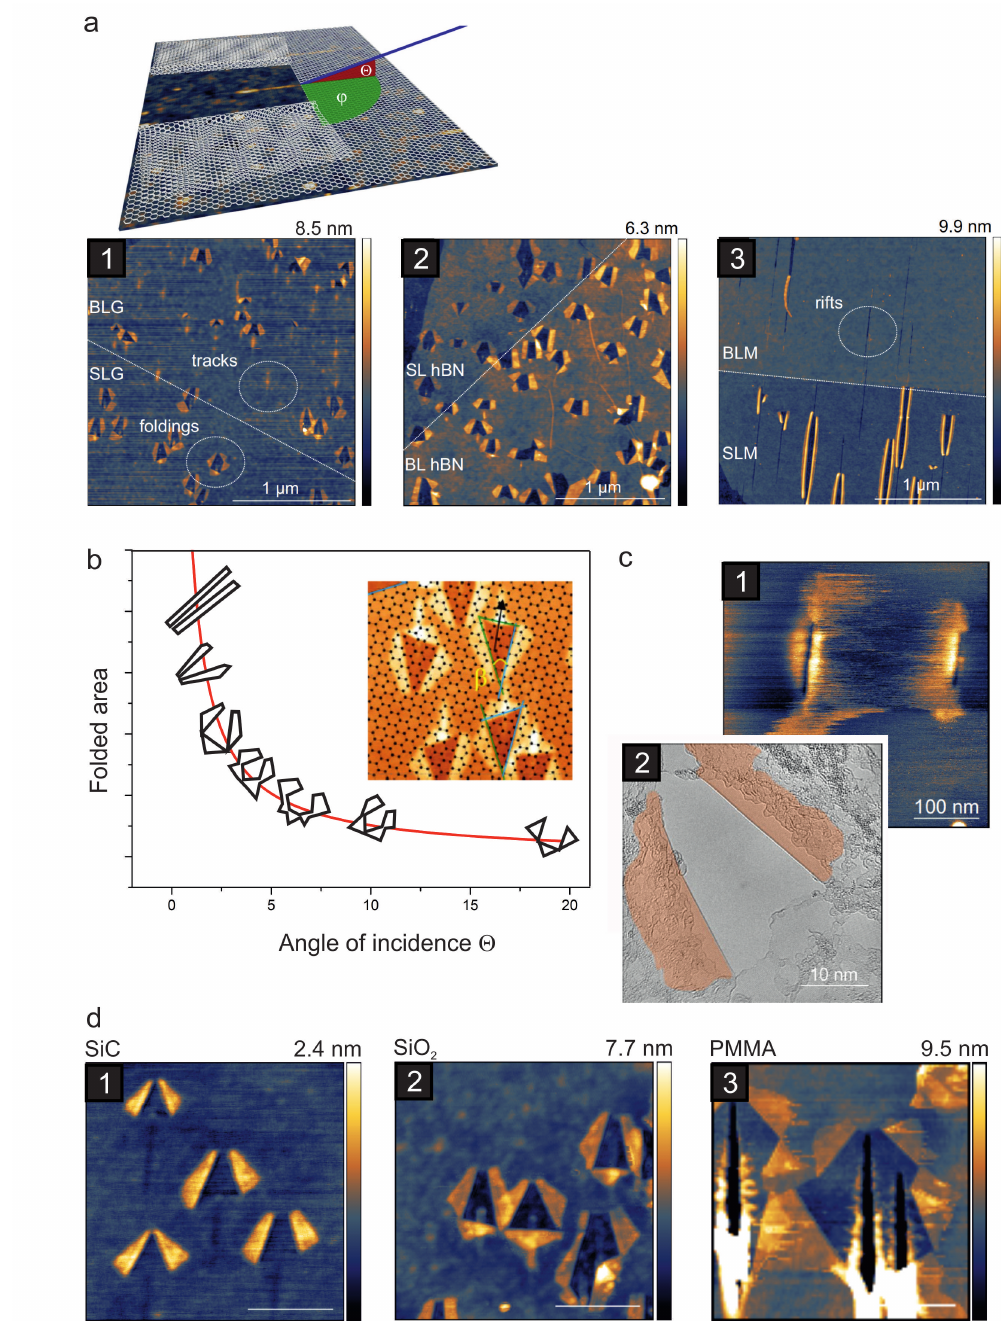
Figure 8. Folding of graphene and other 2D materials by SHI irradiation. ( a ) The sketch visualizes the backfolded graphene after an ion has impinged onto the surface under a grazing angle of incidence Θ . c (cid:13) IOP Publishing. Reproduced with permission from Ref. [112]. All rights reserved. Irradiation induced foldings as imaged by AFM in ( a1 ) single and bilayer graphene, ( a2 ) hBN, and ( a3 ) MoS 2 , from Ref. [113]. ( b ) The shape of the graphene folding pattern (outlines shown in ( b ) are taken from AFM images) depends strongly on the angle of incidence. At larger angles the pattern consist of multiple foldings oriented along low-indexed crystallographic directions of the graphene [114] as shown in the inset in ( b ), while under very grazing incidence the azimuthal angle determines the direction of the two foldings, which are aligned along the ion trajectory, see Ref. [112]. ( c , d ): The substrate also influences shape and size of the foldings. AFM images of suspended graphene show slits ( c1 ), which in fact are small foldings as can be seen in atomically resolved TEM images ( c2 ); ( d1 ) SiC-substrate, ( d2 ) SiO 2 -substrate, ( d3 ) Poly(methyl methacrylate)-substrate. Scale bars are 400 nm. c (cid:13) IOP Publishing. Reproduced with permission from Ref. [112]. All rights